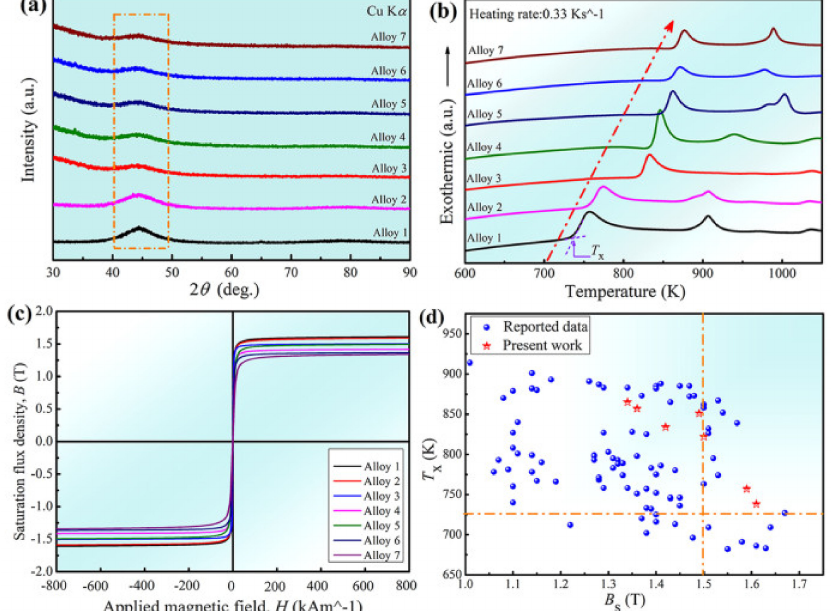
Figure 4. ( a ) X-ray diffraction patterns, ( b ) differential scanning calorimetry curves, ( c ) hysteresis loops, and ( d ) saturation polarization and Tx of designed (modeled via ML) and experimental Fe-based metallic glasses. Further information